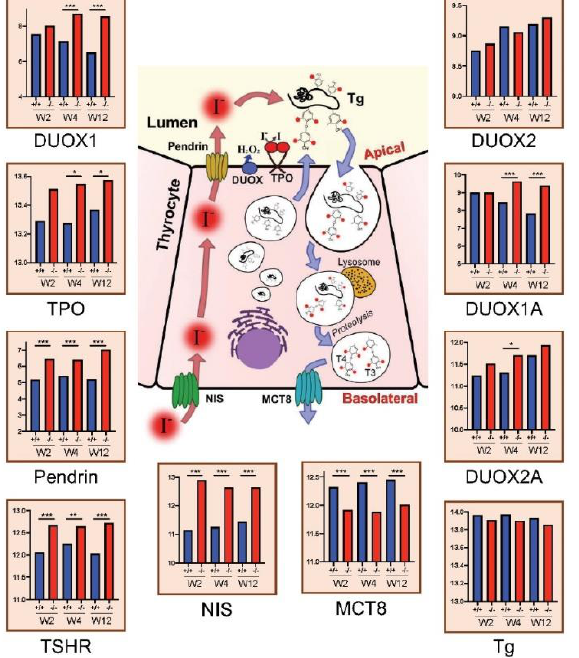
Figure 3. Gene expression of TH biosynthesis-related genes in thyroid glands at W2, W4 and W12 from microarray data (N = 4 in each group). Data are expressed as the Mean values. * p < 0.05, ** p < 0.01, *** p < 0.001. Table 1. Differentially expressed gene-set clusters in thyroid glands between Xb130 +/+ and Xb130 − / − mice. Gene-set clusters enriched in Xb130 +/+ group. Gene-set clusters enriched in Xb130 − / −